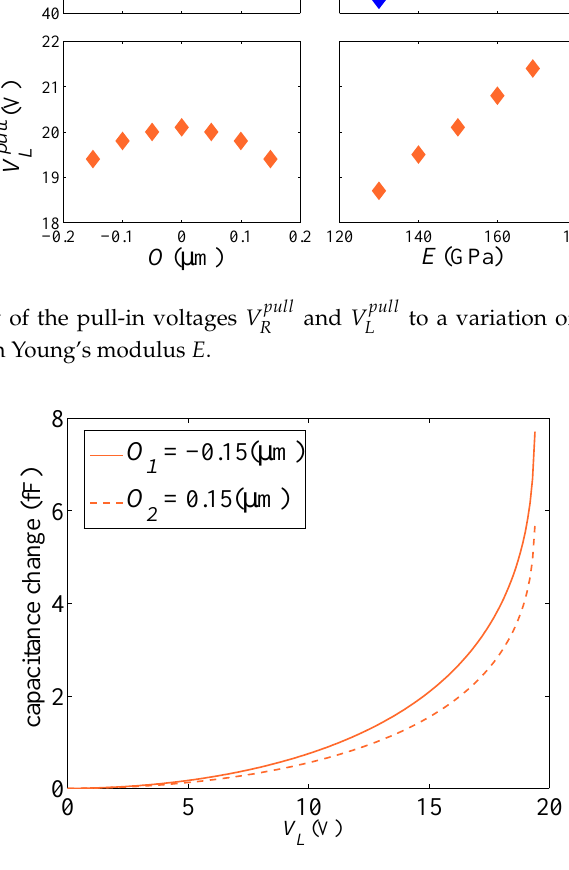
Figure 6. Comparison between the electro-mechanical responses of two devices respectively featuring O 1 = − 0.15 µ m (solid line) and O 2 = 0.15 µ m (dashed line), with E 1 = E 2 = ¯ E